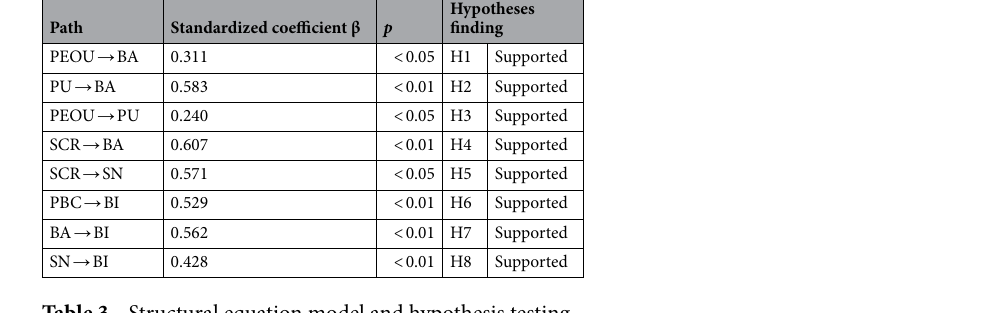
Table 3. Structural equation model and hypothesis